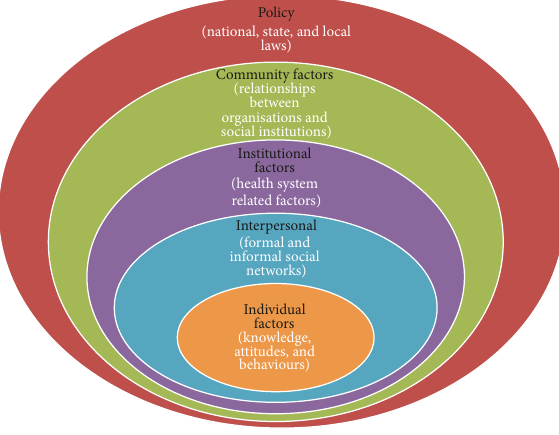
Figure 1: The ecological model